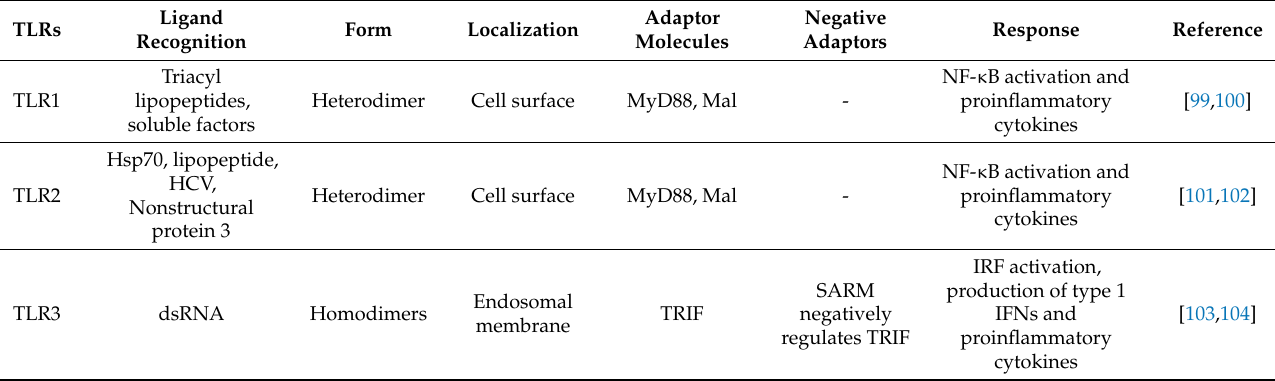
Figure 2. SARS-CoV-2 causes infection in the lungs mainly via DAMPs and PAMPs produced as a result of the action of nearly all Toll-like receptors (TLRs). Only TLRs involved in virus sensing and/or signaling are displayed here. Table 3. Toll-like receptors (TLRs) and their physiological